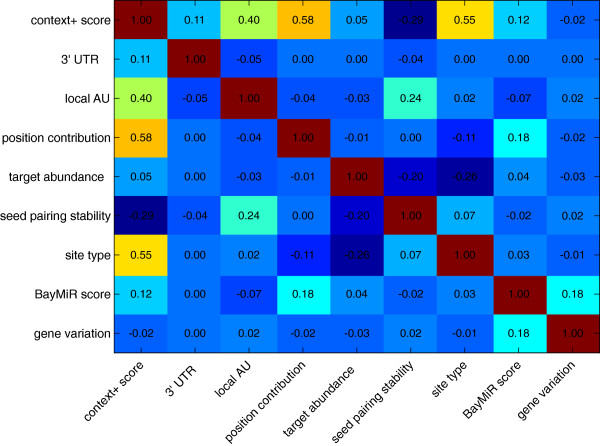
Correlation between different determinants. The heat map shows the Pearson correlation coefficients between each pair of nine determinants. A “0.00” correlation is shown for correlation coefficients that are not significantly different from 0 (P > 0.05).